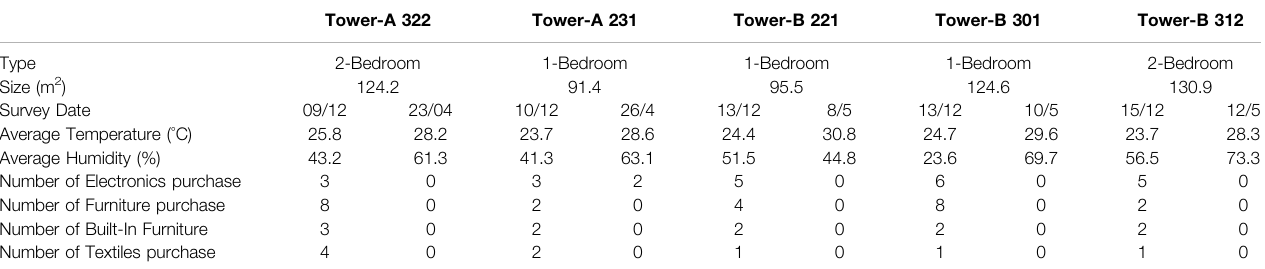
TABLE 6 | Investigation on the indoor pollutant sources of target residential